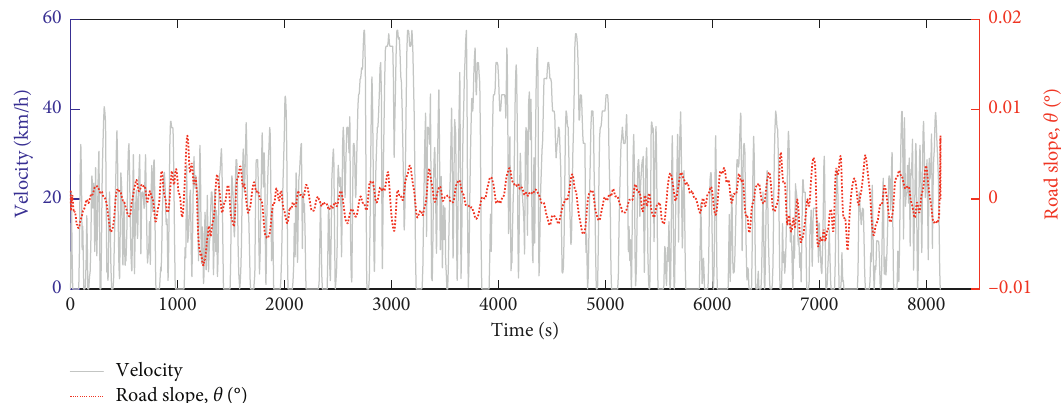
Figure 8: The synthesized driving cycle including velocity and road slope. Table 2: Comparison of the statistical properties for the synthesized cycle and measured cycles.